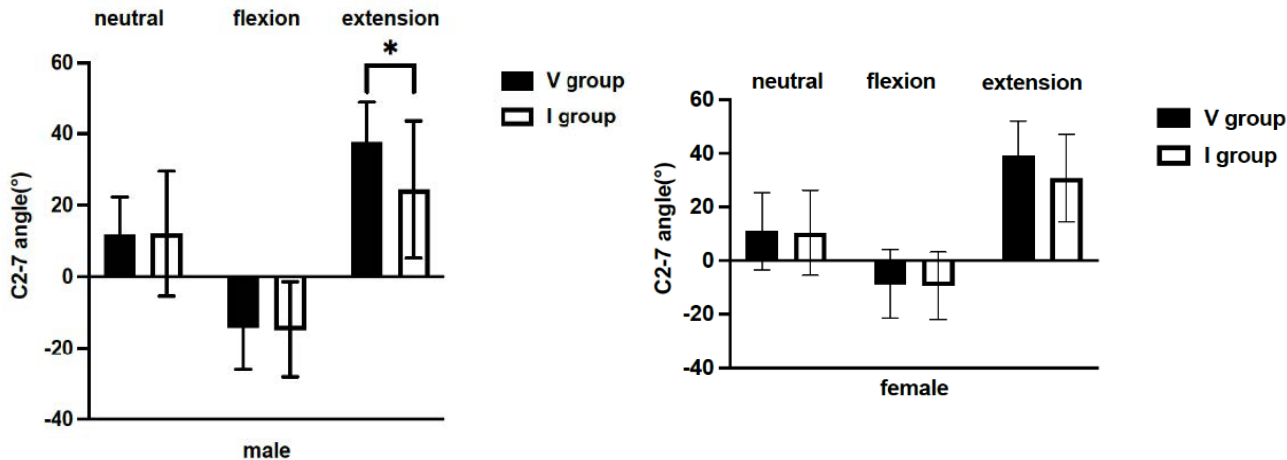
Figure 3. Comparison of the C2-7 angles between the I and V groups in neutral, flexion, and extension in males and females. *: p < 0.05; V group, T1 slope visible; I group, T1 slope invisible. Thus, male patients with greater C2-7 SVA had an invisible T1 slope, as shown in the representative cases in Figure 4A,B.